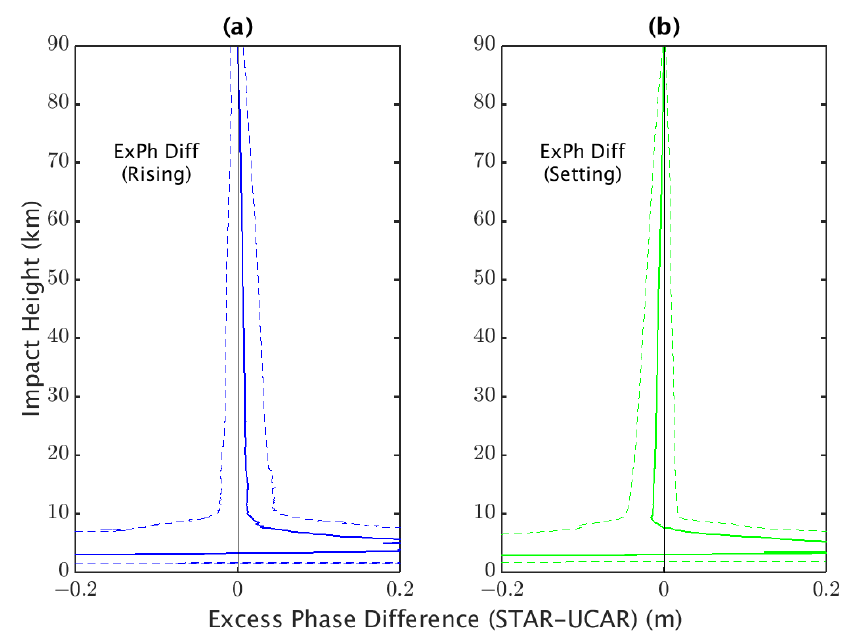
Figure 5. Excess Phase comparison between STAR and UCAR results (STAR-UCAR) for ( a ) rising and ( b ) setting for day 2019.275. The impact height is derived based on the geo-optical method from L1. The Solid line represents difference, and the dashed line represents standard deviation.